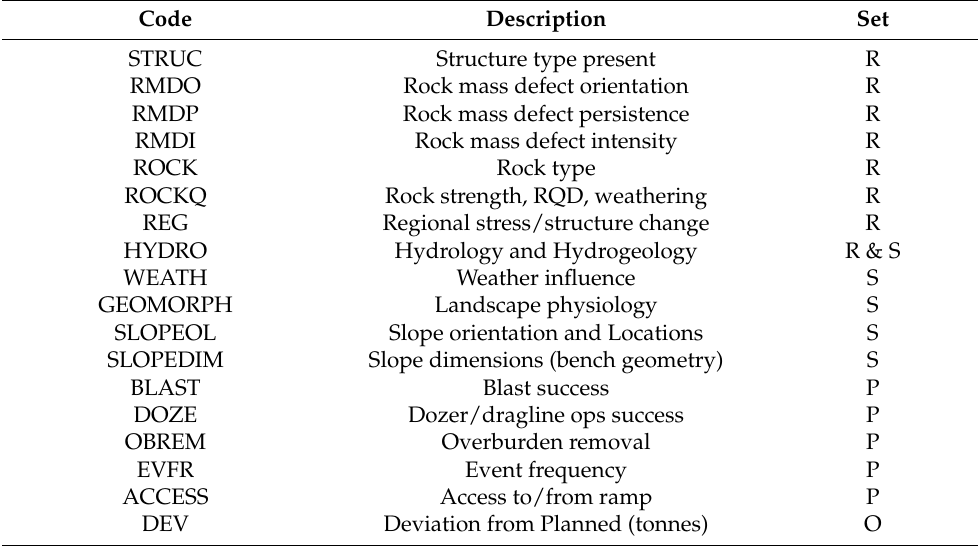
Table 1. Parameters used in initial RES matrix (R = rock, S = site, P = project engineering, O = output).